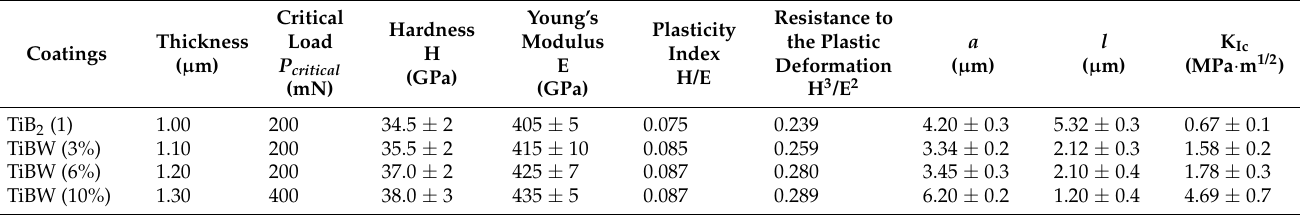
Table 2. The characteristic parameters of thickness, critical load, hardness, Young’s modulus, H/E and H 3 /E 2 for TiB 2 (1) and TiBW coatings were used for the calculation of the K Ic coefficient by using the Laugier model